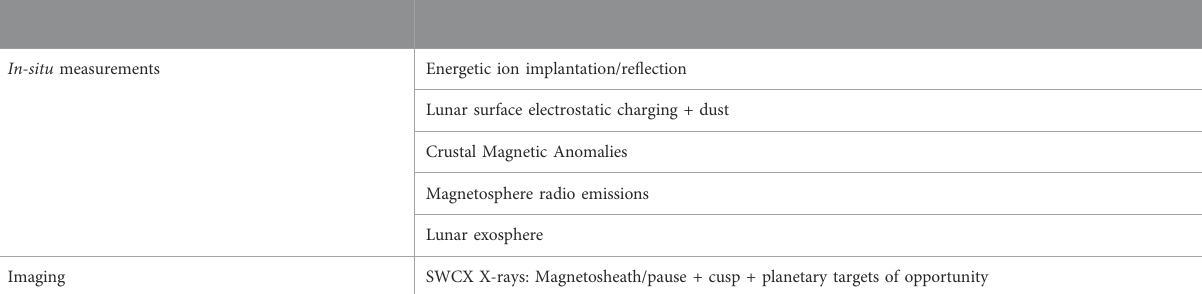
TABLE 3 Physical parameter/observable to be monitored from the lunar surface.